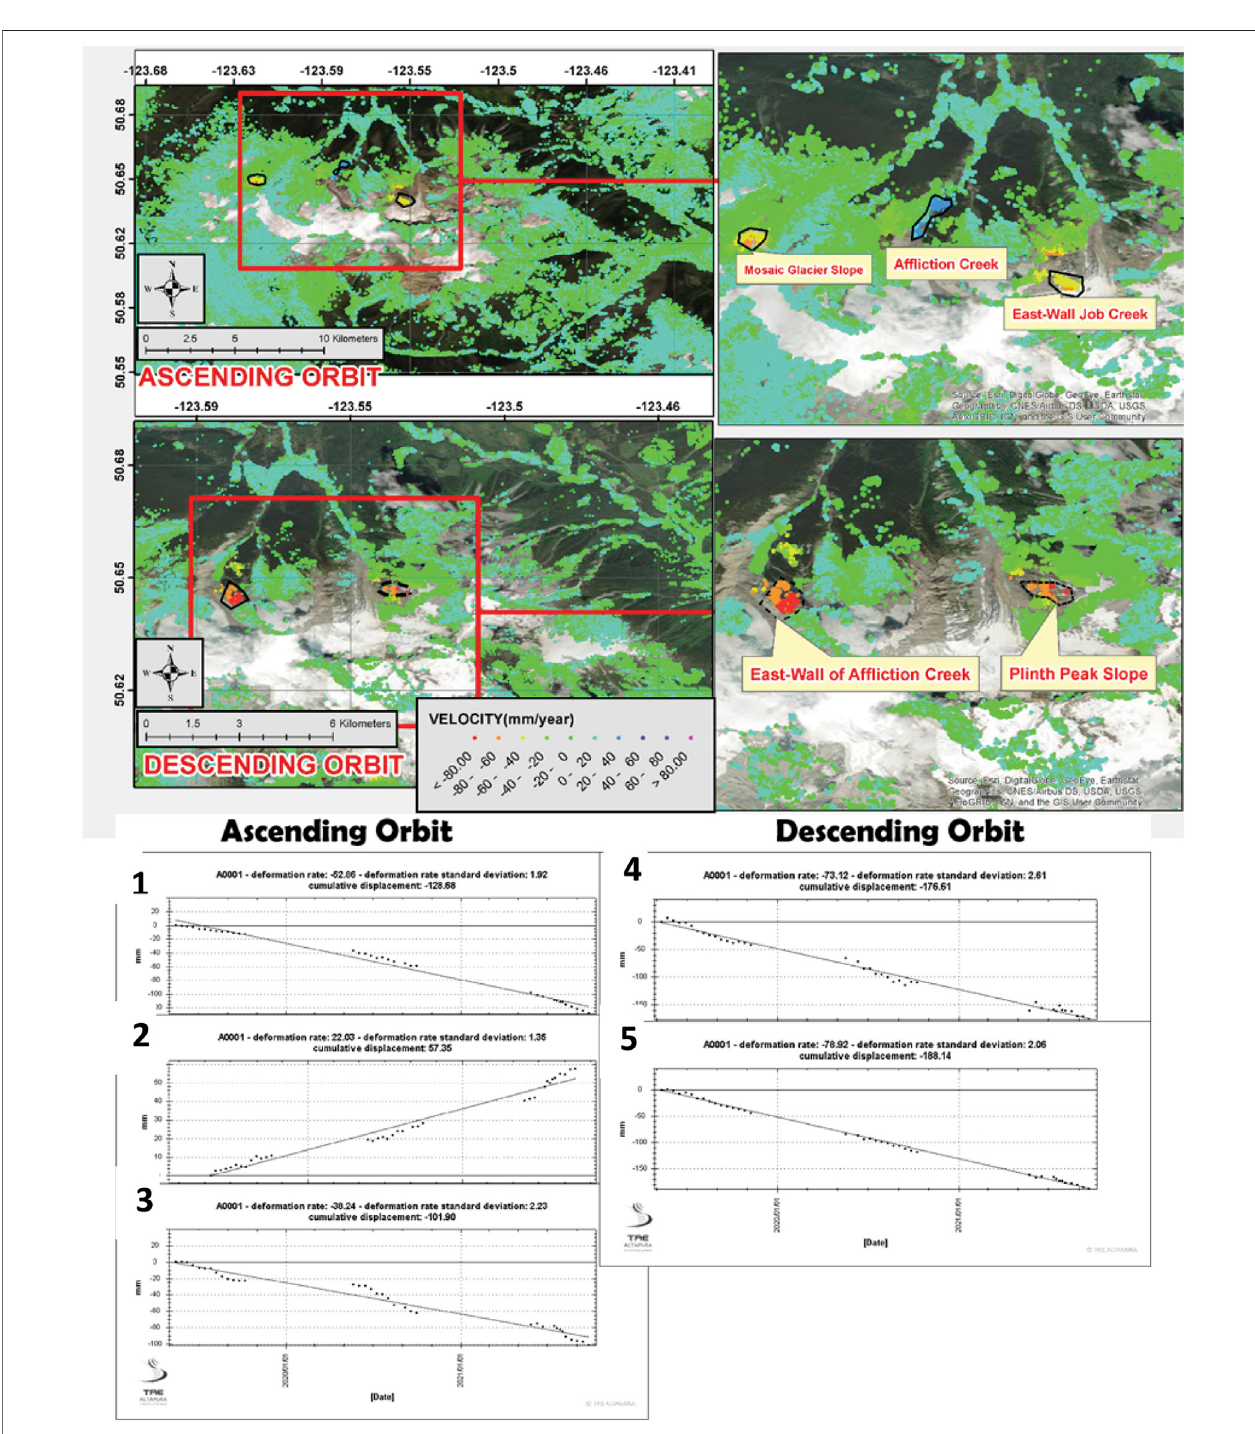
FIGURE2| SqueeSARresultsshowdeformationrateinmm/yearNorthoftheMountMeagermassif;seeblueinsetin Figure1B forthelocation.Notetheimpactof LineofSight(LOS)limitationtocaptureslopedeformationforbothascendinganddescendingsatelliteorbits.Thegraphsshowthetemporaldeformationratefor1)East- wall Job Creek. 2) Af fl iction Creek 3) Mosaic Creek slope in the ascending orbit, and 4) Plinth Peak slope, and 5) East-wall Af fl iction Creek in the descending orbit.